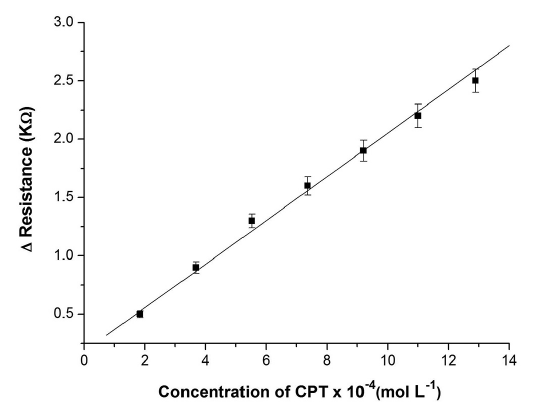
FIGURE 4 - Analytical curve for determination of